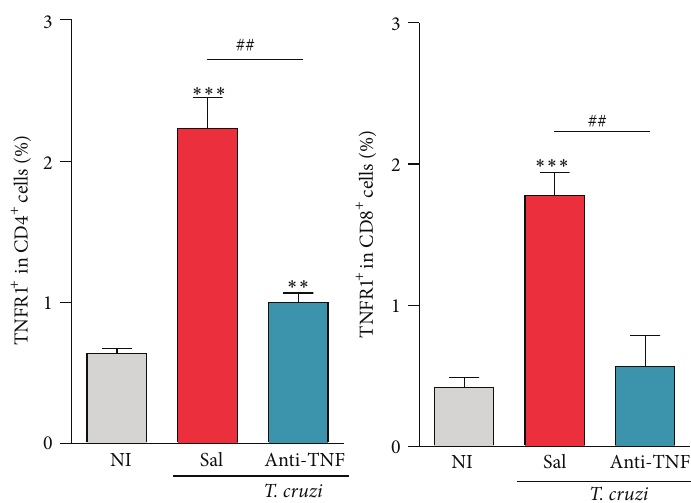
Figure 3: Anti-TNF administration reduces the frequency of TNFR1-expressing CD4 + and CD8 + T-cells in chronically Trypanosoma cruzi - infected mice. C57BL/6 mice infected with 100 bt of the Colombian T. cruzi strain were treated from 120 to 150 dpi and analyzed at 150 dpi. Frequency of TNFR1 + cells among CD4 + and CD8 + T-cells in the spleen [R1 (SSCxFSC) gated]. ∗∗ 𝑃 < 0.01 and ∗∗∗ 𝑃 < 0.001 , T. cruzi - infected mice (saline injected or anti-TNF treated) compared to NI controls. ## 𝑃 < 0.01 , anti-TNF-treated compared to saline-injected T. cruzi -infected mice. Bar represents the mean ± SD of the studied group (4 to 6 mice). These data represent two independent